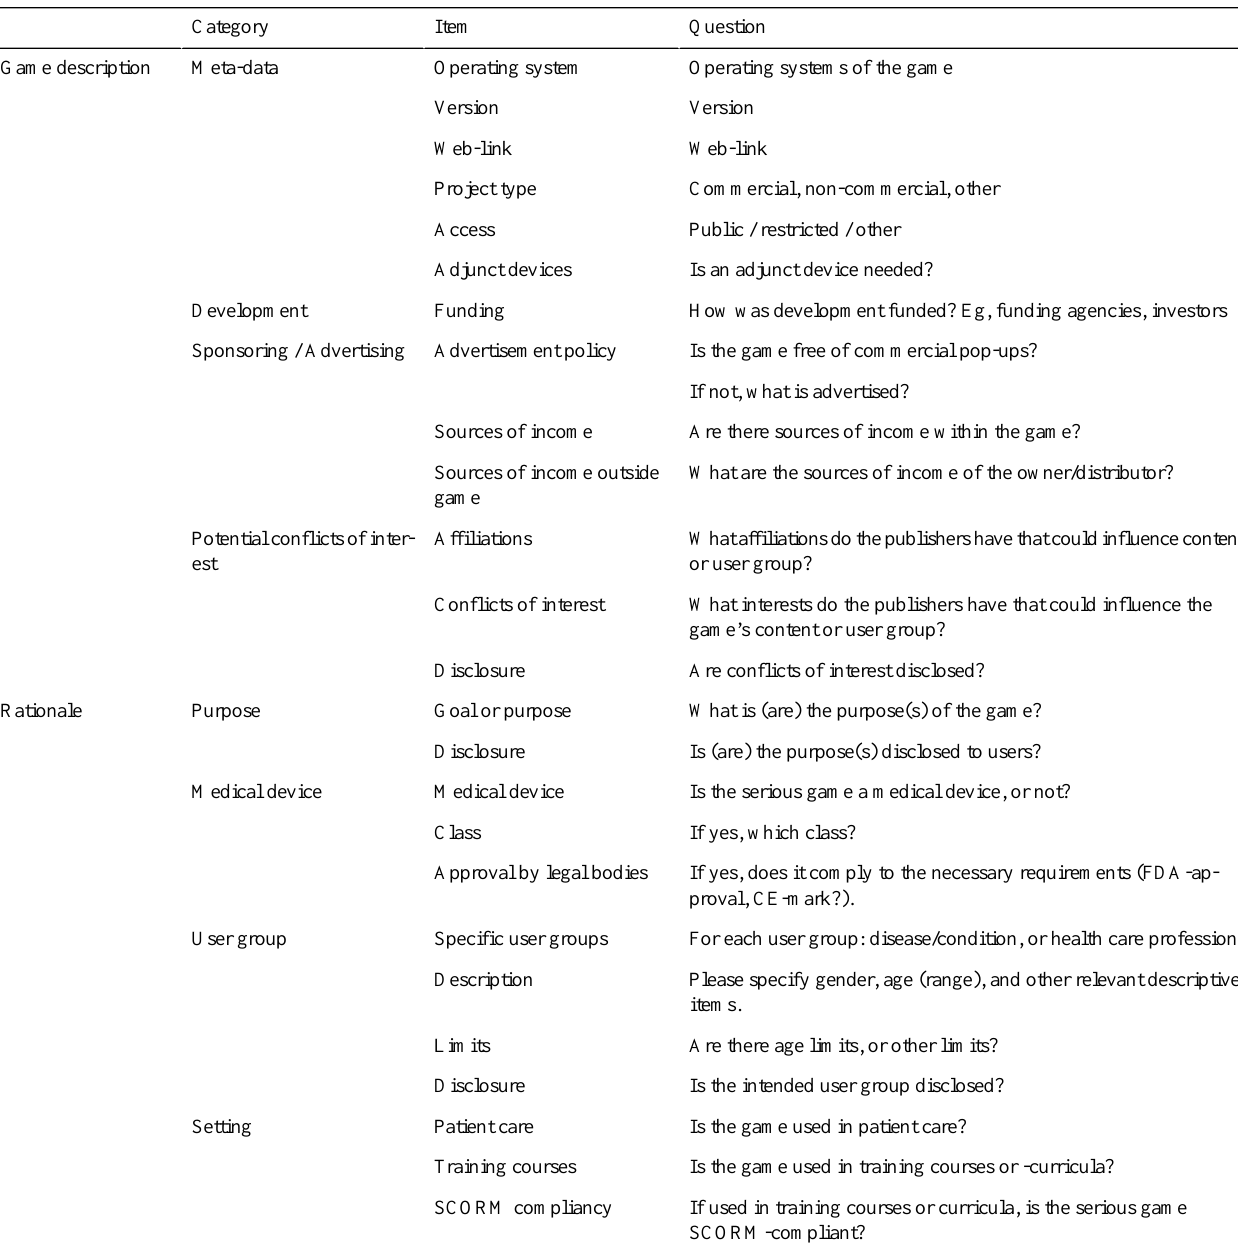
Table 1. Items relevant for the assessment of a serious game used for health care-related